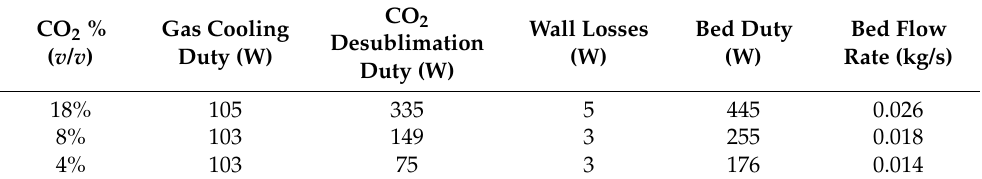
Table 7. Simulated moving bed energy duties and bed flow rate for various CO 2 concentrations using Equation (14).